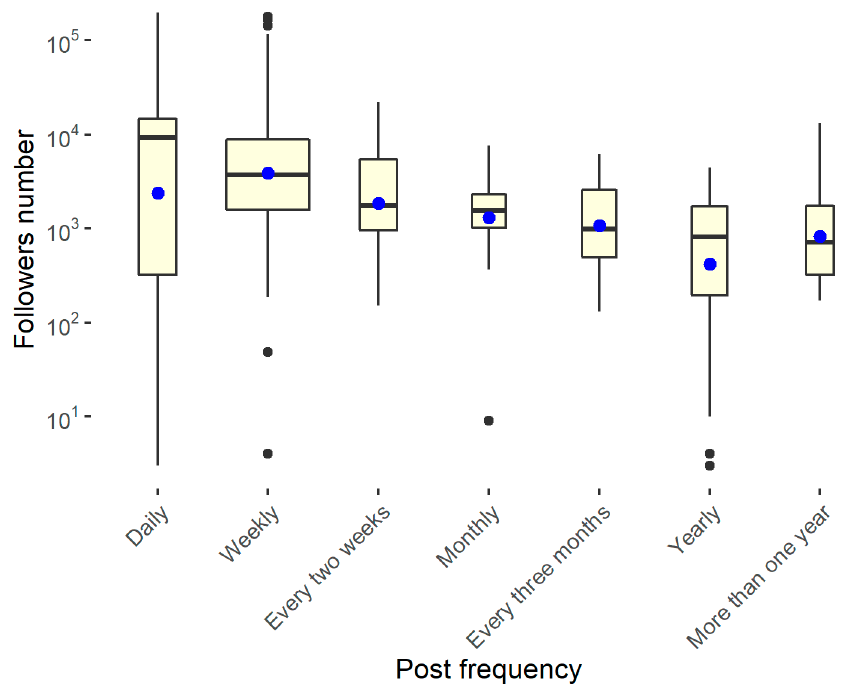
Figure 8. Comparison between the number of followers and post frequency.